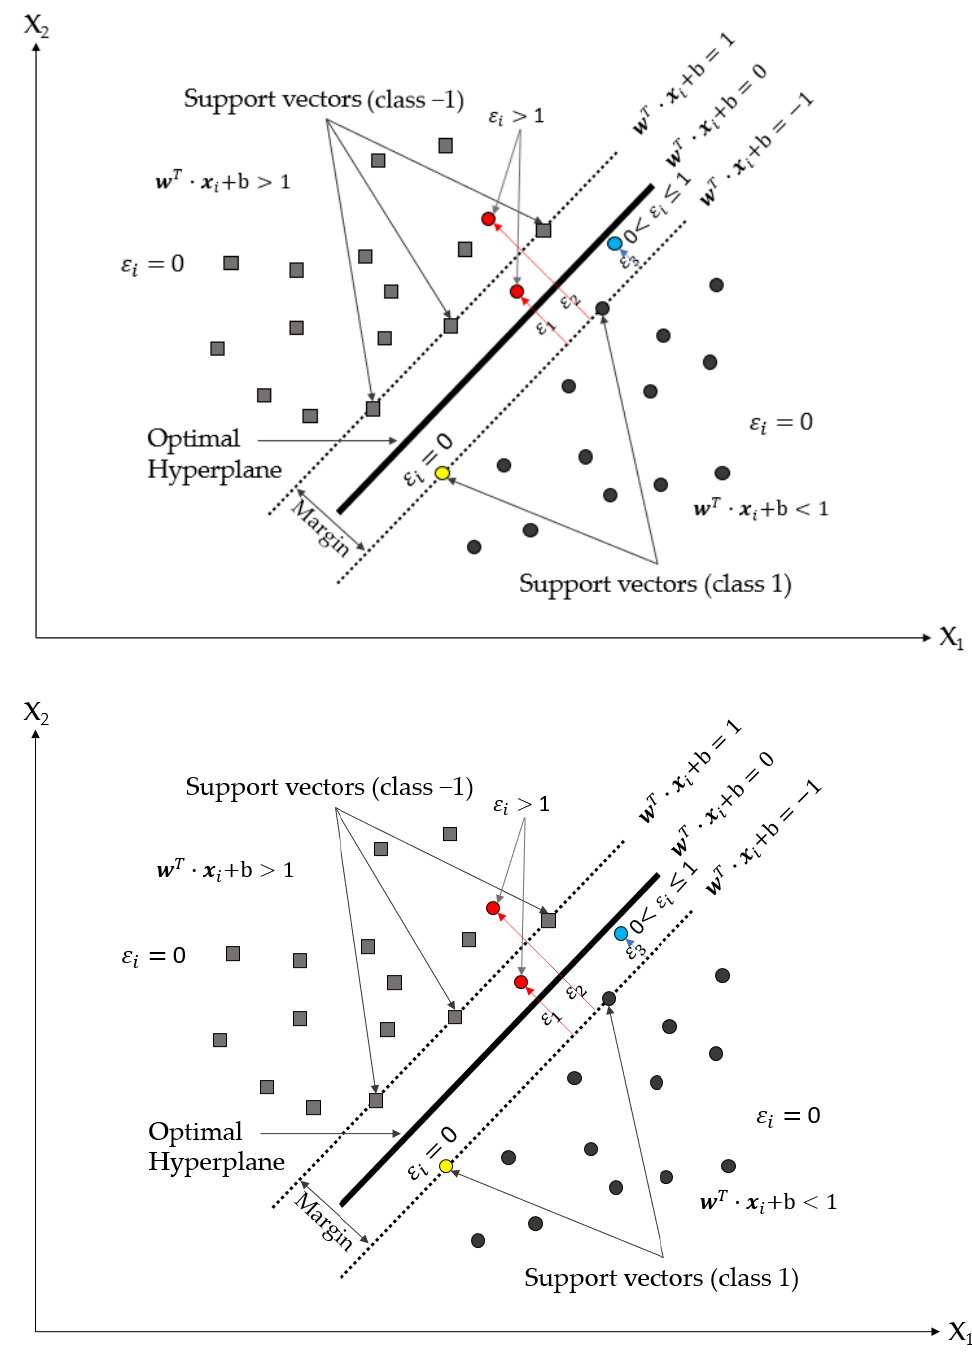
Figure 2. Support Vector Machine (Murphy in 2012) [36].